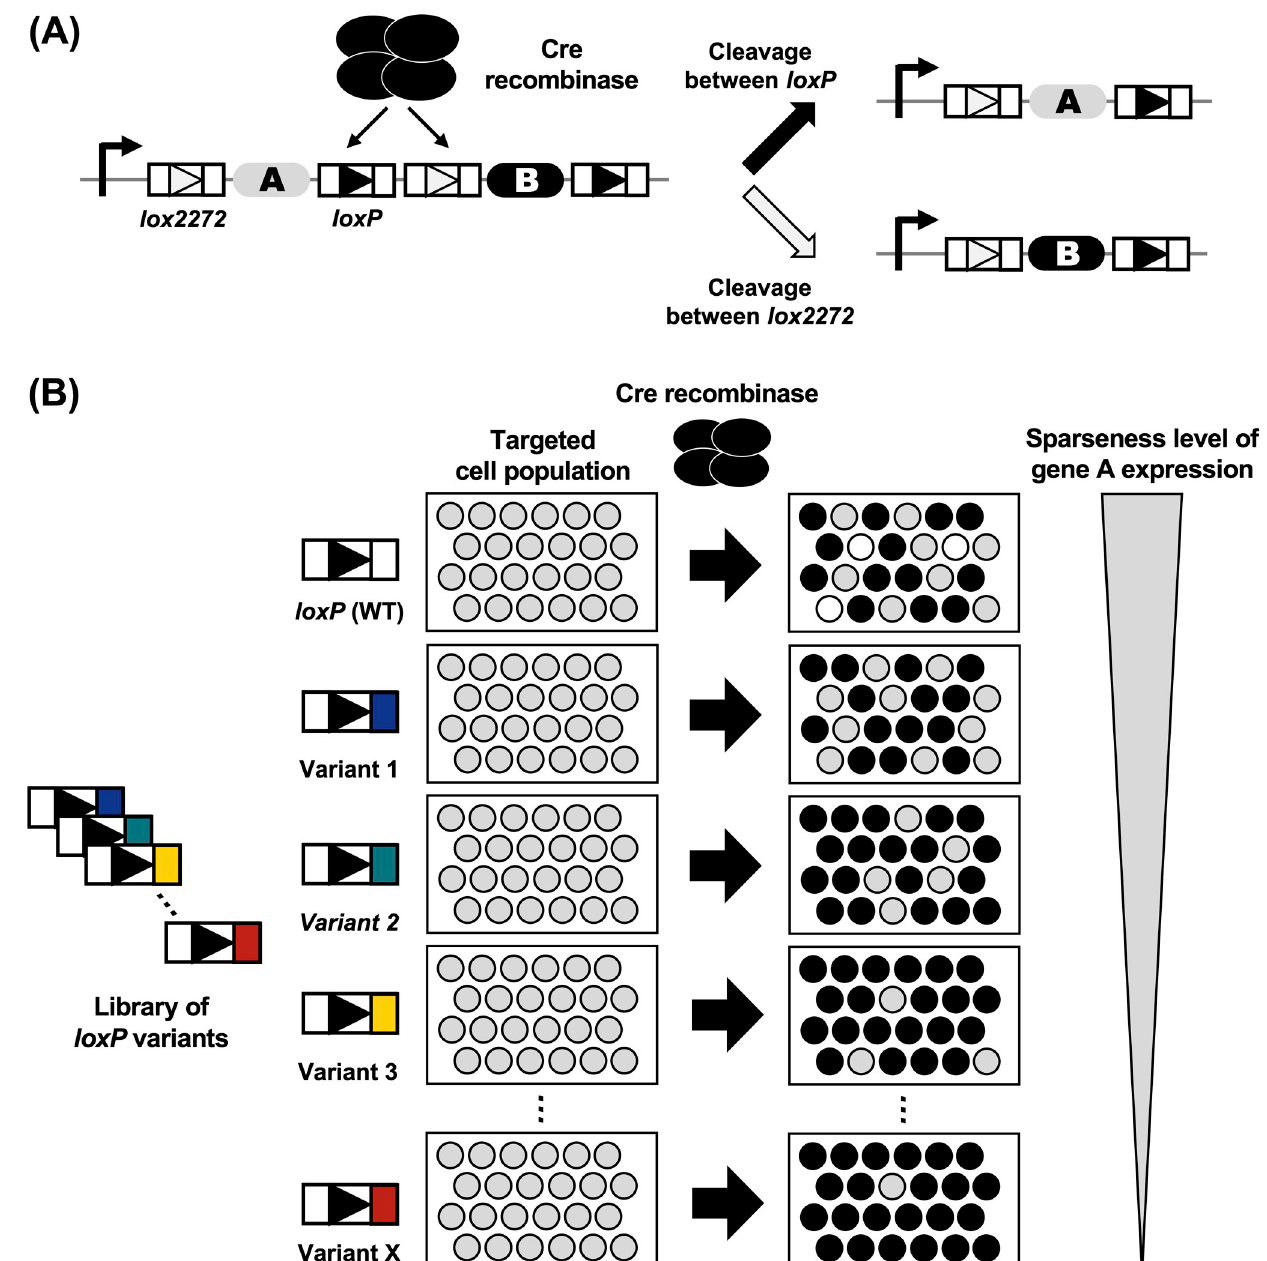
Fig 1. Schematic overview of our strategy. (A) Stochastic excision of lox sequences by Cre. Gene A is excised when Cre cleaves lox2272 sequences and gene B is excised when Cre cleaves loxP sequences. Cre cleaves one of two pairs of lox sequences (a pair of lox2272 sequences or a pair of loxP sequences) in a mutually exclusive way, which leads to the exclusive expression of gene A or gene B. (B) Regulation of the sparse labeling rate using loxP variants. We hypothesized that mutations in loxP sequences affect the affinity of the loxP sequence against Cre, thus rendering them less likely to be cleaved by